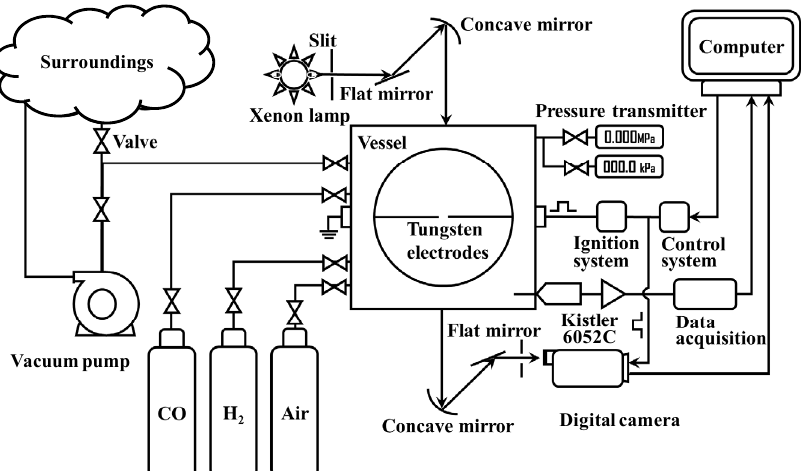
Figure 1. Schematic diagram of the experimental